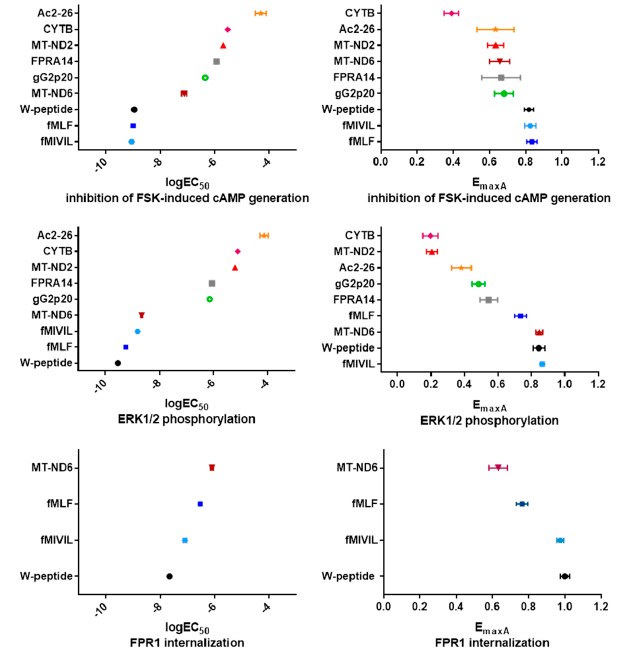
Figure A5. Depiction of logEC 50 and E maxA values of each pathway. Ligands are arranged according to the intensity of the response they elicited in the respective pathway. Data are expressed as mean ± SEM after outlier removal. Table A1. Ligand stock solutions. Concentrations of stock solutions were calculated based on the solubility of the compound as indicated by the manufacturer and its molecular weight (M). Stock solutions were prepared using the solvents recommended by the manufacturer.